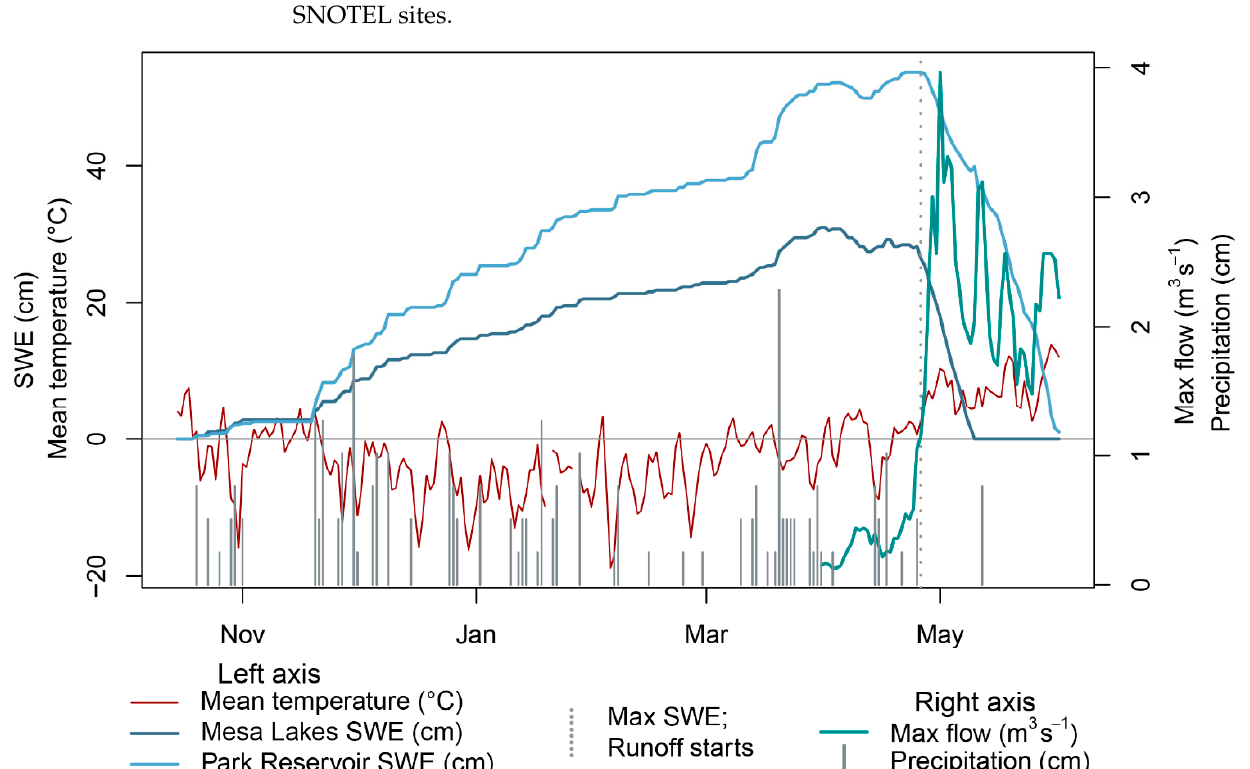
Figure 4. Mean daily temperature, precipitation, and accumulated SWE from Mesa Lakes Snotel site, accumulated SWE from the Park Reservoir Snotel site, and daily maximum streamflow measured from USGS Surface Creek gauge. Mean temperature ( red ) and SWE ( blues ) values are on the left axis scale; maximum daily streamflow ( cyan ) and incoming precipitation ( grey bars) values are on the right axis scale.